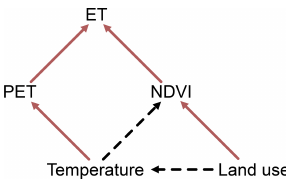
Figure 3. Separating local and climatic drivers of evapotranspira- tion (ET). Temperature ( T ) modulates ET directly, through the ef- fect on potential evapotranspiration (PET), or indirectly, by chang- ing growing conditions, vegetation structure, and phenology and, therefore, NDVI. Land use modulates ET directly, by changing land cover characteristics, or indirectly, by affecting air temperature. We evaluate the effects depicted by the solid red lines and decouple the effects of the dashed lines via the Hargreaves model and maps of land use change (see the text for